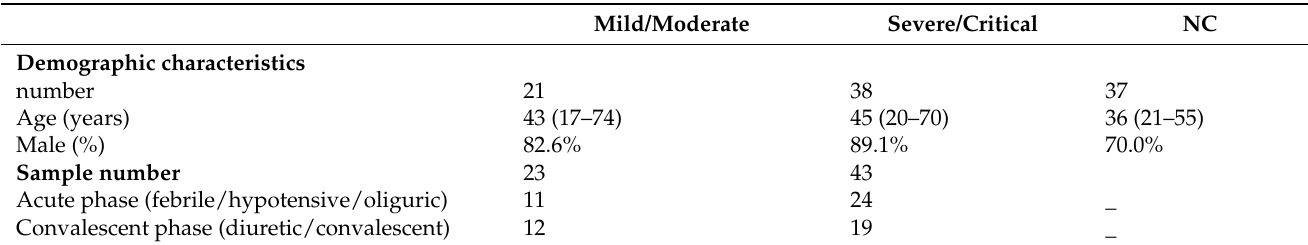
Table 1. Characteristics of enrolled subjects.